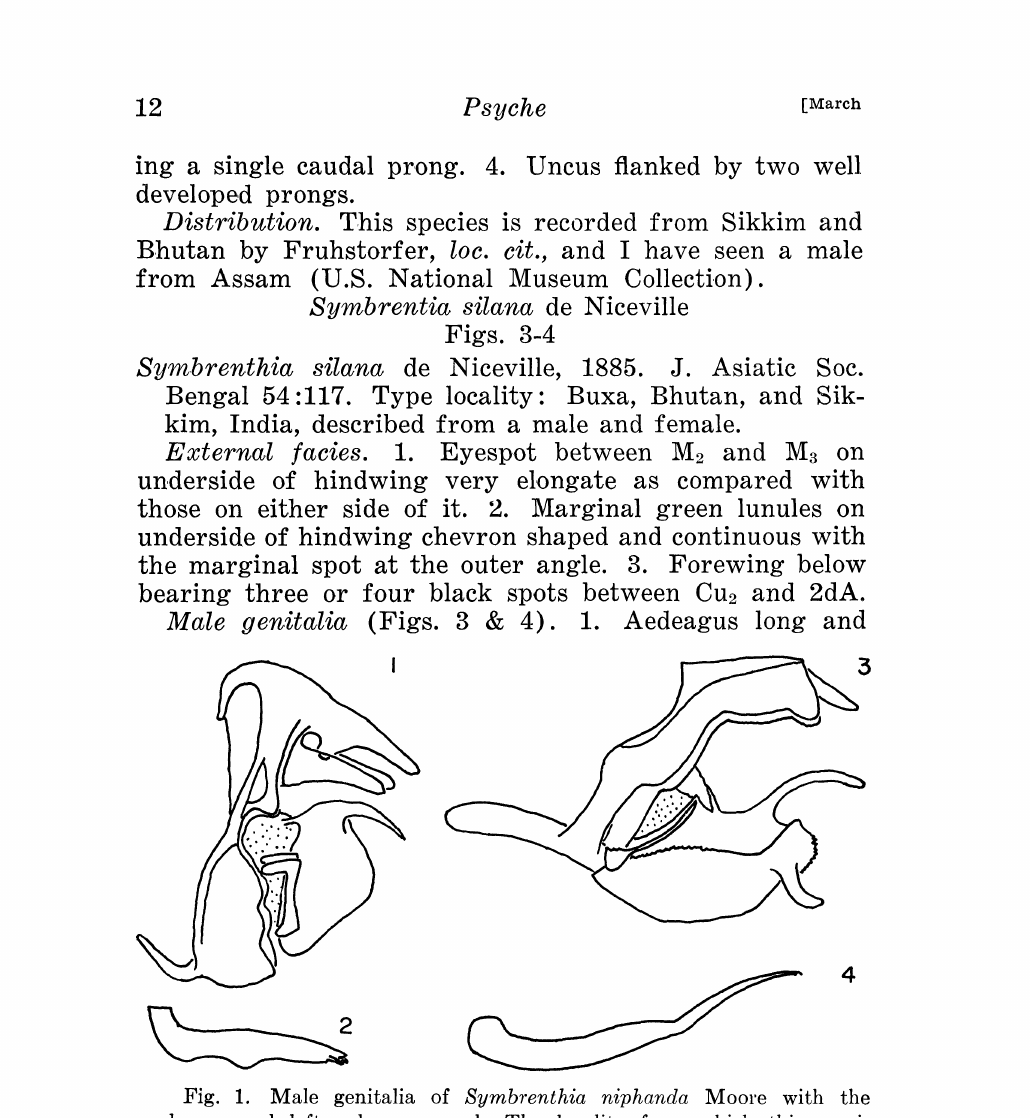
Fig. 1. Male genitalia of Symbrenthia niphanda Moore with the aedeagus and left valve removed. The locality from which this speci- men came is unknown. Fig. 2. Aedeagus of the genitalia in Fig. 1. Fig. 3. Male genitalia of Symbrenthia silana de Niceville with the aedeagus and left valve removed. This specimen was collected at Sivoke, Sikkim. Fig. 4. Aedeagus of the genitalia in Fig. 3. All views are of the lateral aspect at 45x. Both specimens are in the collection of the U.S. National